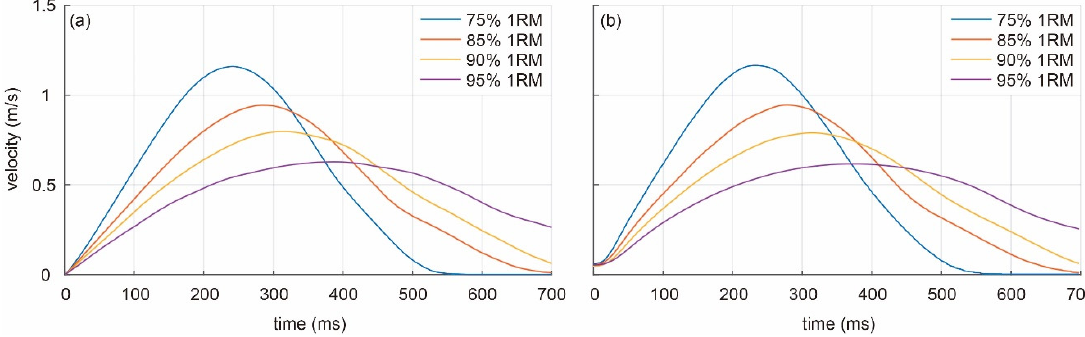
Figure 7. Velocity–time curves averaged across all subjects for ( a ) LPT system and ( b ) video system. Blue line: 75% 1RM; red line: 85% 1RM; yellow line: 90% 1RM; purple line: 90% 1RM.